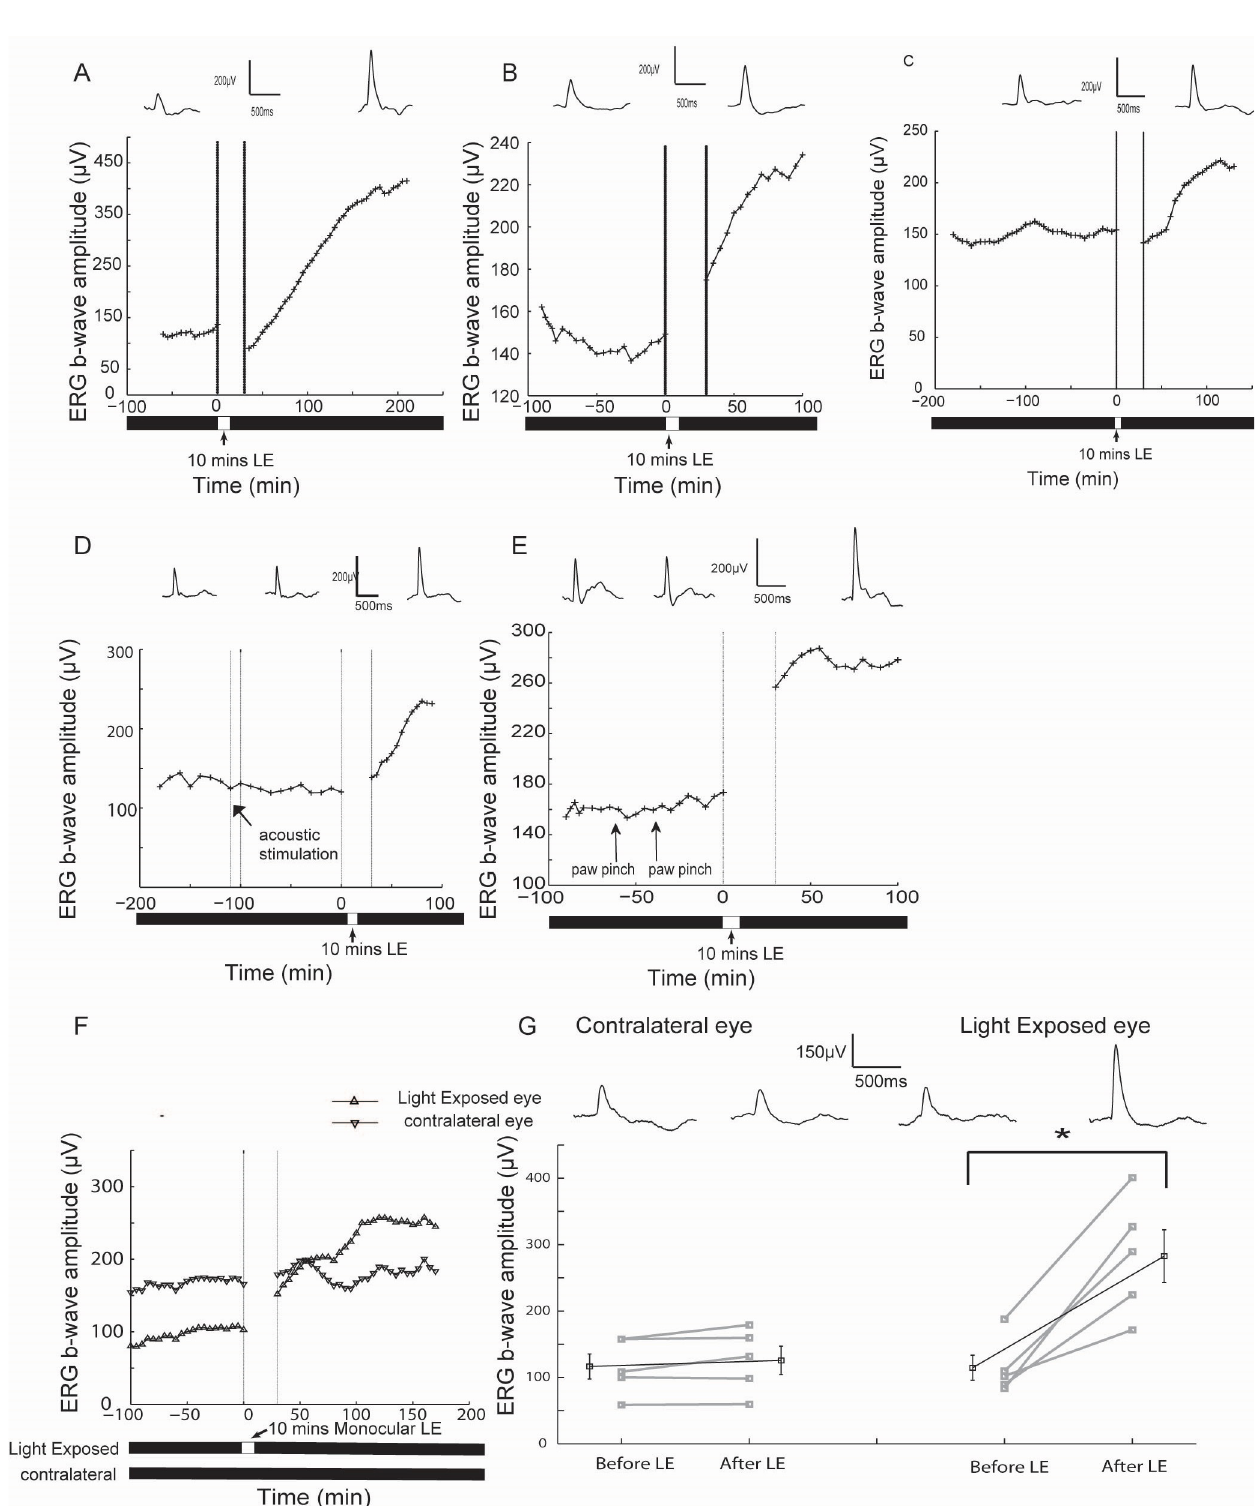
Fig 4. Prolonged dark exposure induced suppression was restored by a subsequent light exposure with eye specificity. (A-C) Three typical cases showing that ERG b-wave amplitudes of the prolonged dark exposed (Prolonged DE) rats after the 10 minutes light exposure (LE). Typical ERG curves before and after light exposure were presented on top of each panel. (D) The ERGs of a Prolonged DE rat after an acoustic stimulation and subsequent 10 minutes light exposure. The acoustic white noise (100dB) lasted for 10 minutes (arrow). (E) The ERGs of a